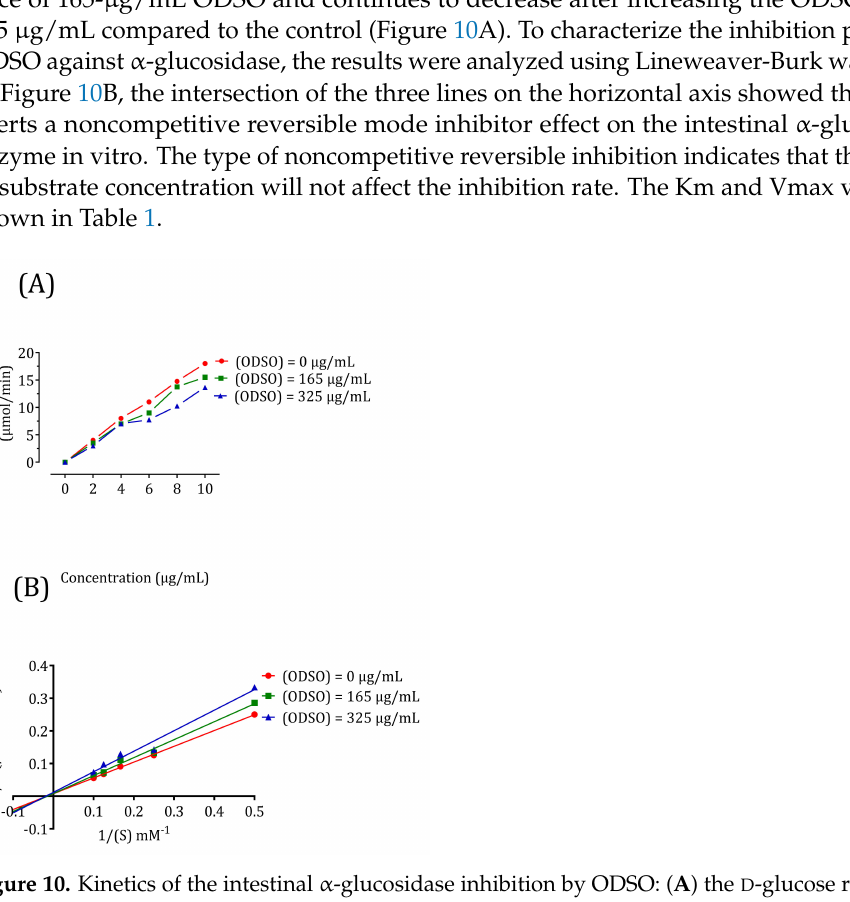
Figure 10. Kinetics of the intestinal α -glucosidase inhibition by ODSO: ( A ) the D -glucose release rate as a function of the sucrose concentration. ( B ) Lineweaver-Burk graph for the kinetic analysis of the intestinal α -glucosidase inhibition by ODSO. ODSO: Opuntia dillenii seed